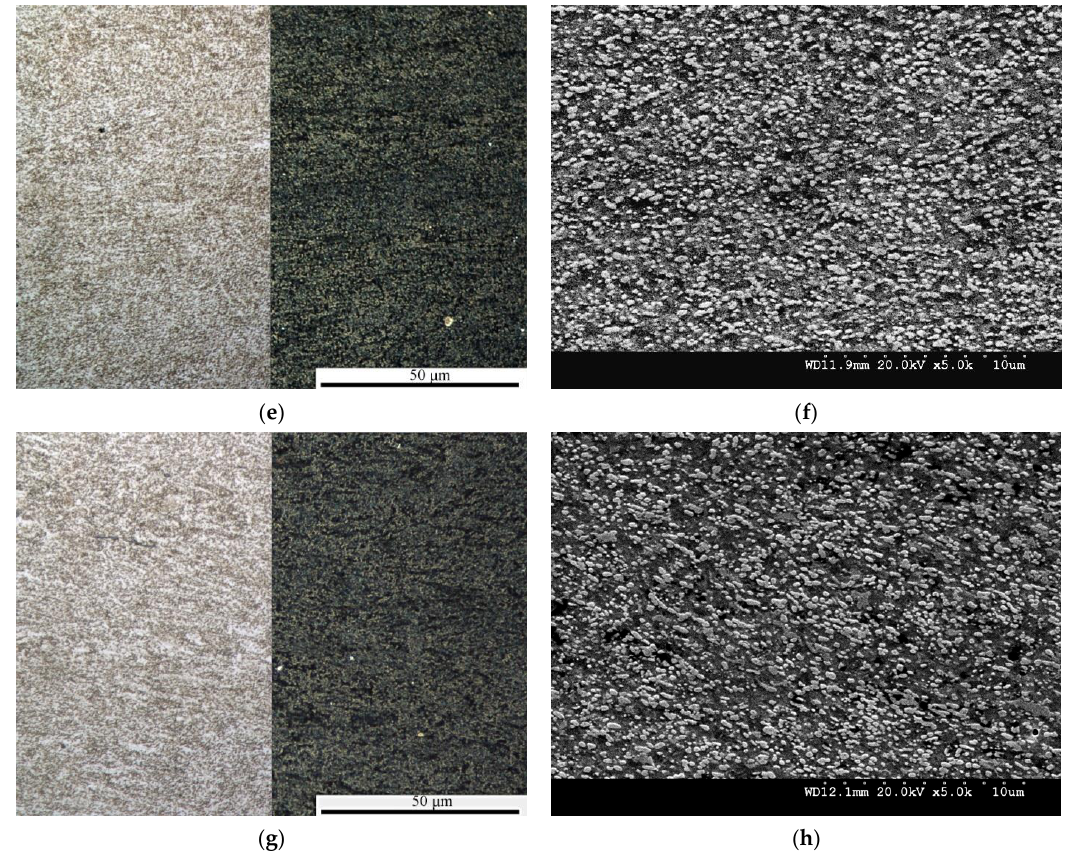
Figure 4. Microstructure of Fe-0,85Mo-0.65Si-1.4C steel after testing with strain rate ( a , b ) 0.001 s −1 , ( c , d ) 0.01 s −1 , ( e , f ) 0.1 s −1 , and ( g , h ) 1 s −1 . Light microscopy (LM) for ( a , c , e , g ) and SEM for ( b , d , f , h ).